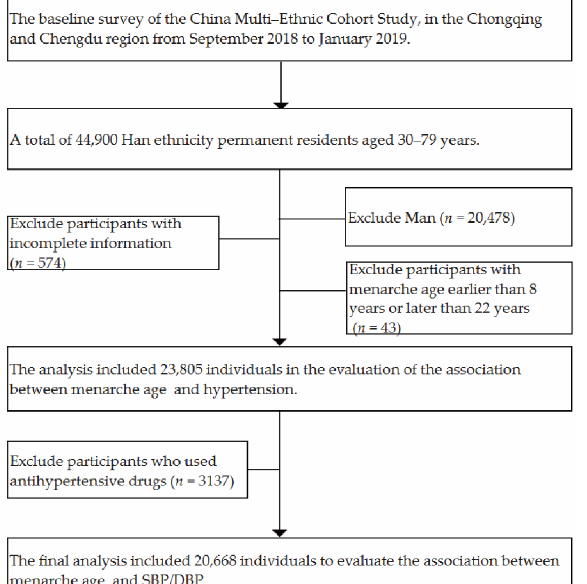
Figure 1. Data cleaning flowchart.